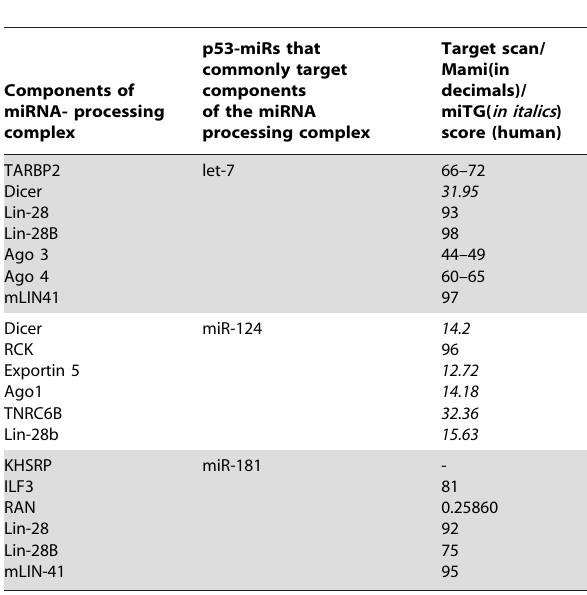
Table 4. p53-microRNAs that target multiple components of the miRNA processing machinery.